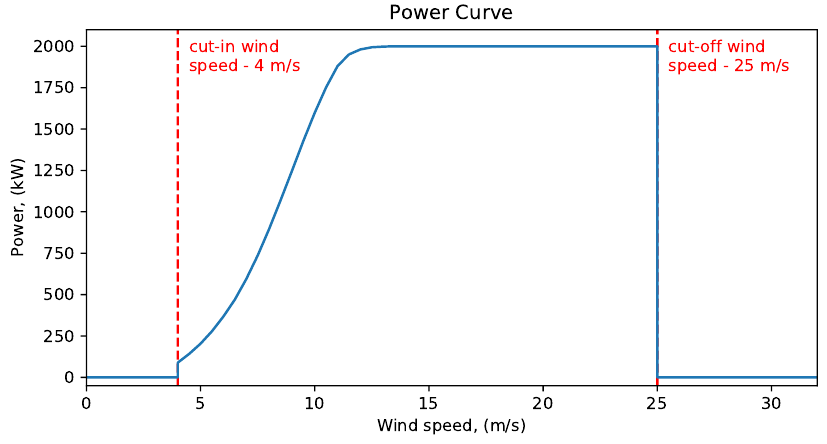
Figure 9. Power curve of the considered wind turbines.